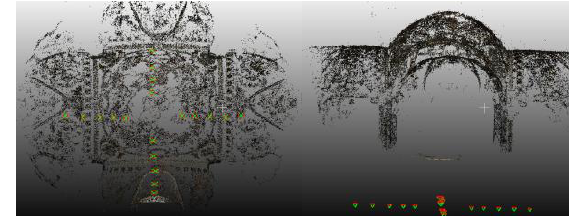
Figure 7 Screen shot of the computed camera location